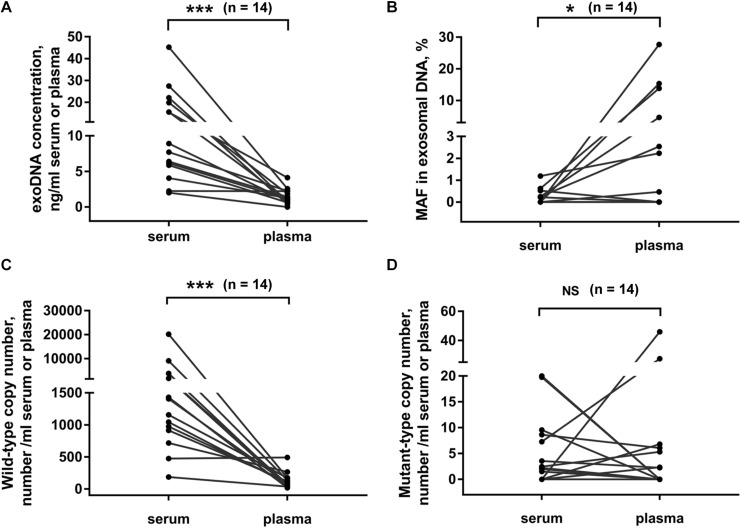
Comparison of exosomal DNA extracted from serum and plasma. DNA concentration (A), MAF of KRAS
(B) and copy number of wild-type (C), and mutant-type (D)
KRAS in exosomal DNA from serum or plasma of PC patients. Matched serum and plasma samples were collected from each patient at the same time point in 14 PC patients. *p < 0.05; ***p < 0.001; NS, not significant.